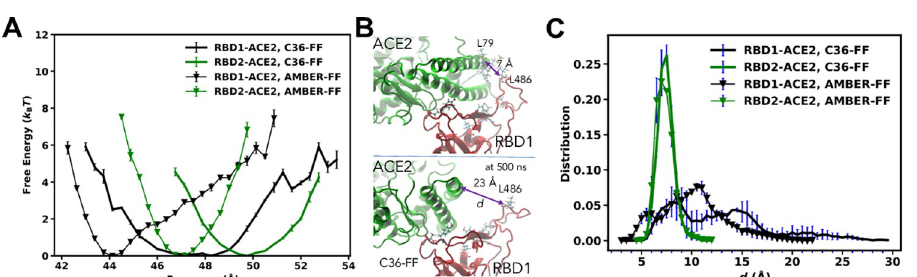
Fig 3. (A) Free-energy profiles computed as a function of the distance between the centers of mass of the RBDs and ACE2 using AMBER and C36 FFs. (B) Snapshots showing an initial configuration of RBD1-ACE complex and its configuration at 500 ns from the simulations using C36 FF. This 500 ns configuration was reproducible and showed in 3 out of 8 replicates (C) Distribution of the distance d between the C α s of L486 of RBD1 and L79 of ACE2 and compared with d of F486-L79 in